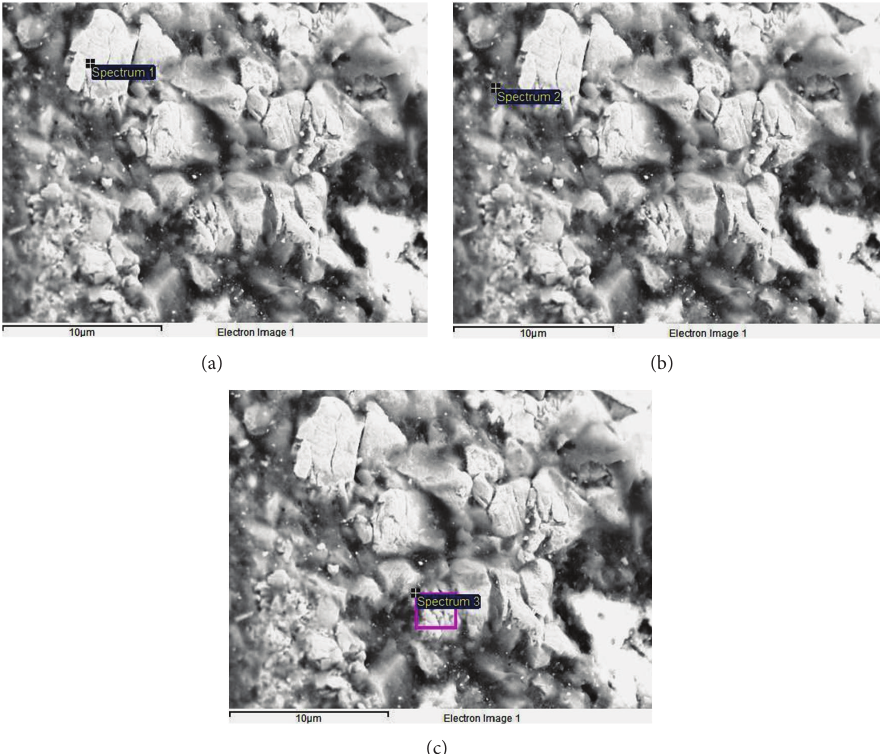
Figure 7: Crushed part of tool tip; different points/area selected for EDS